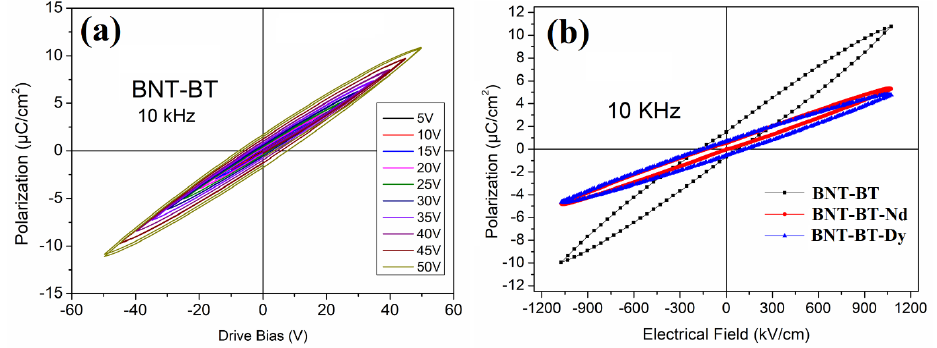
Figure 6. P-E hysteresis loops at room temperature for ( a ) BNT-BT thin films under different applied biases, and ( b ) the comparison of undoped and doped thin films at a 10 kHz test frequency.